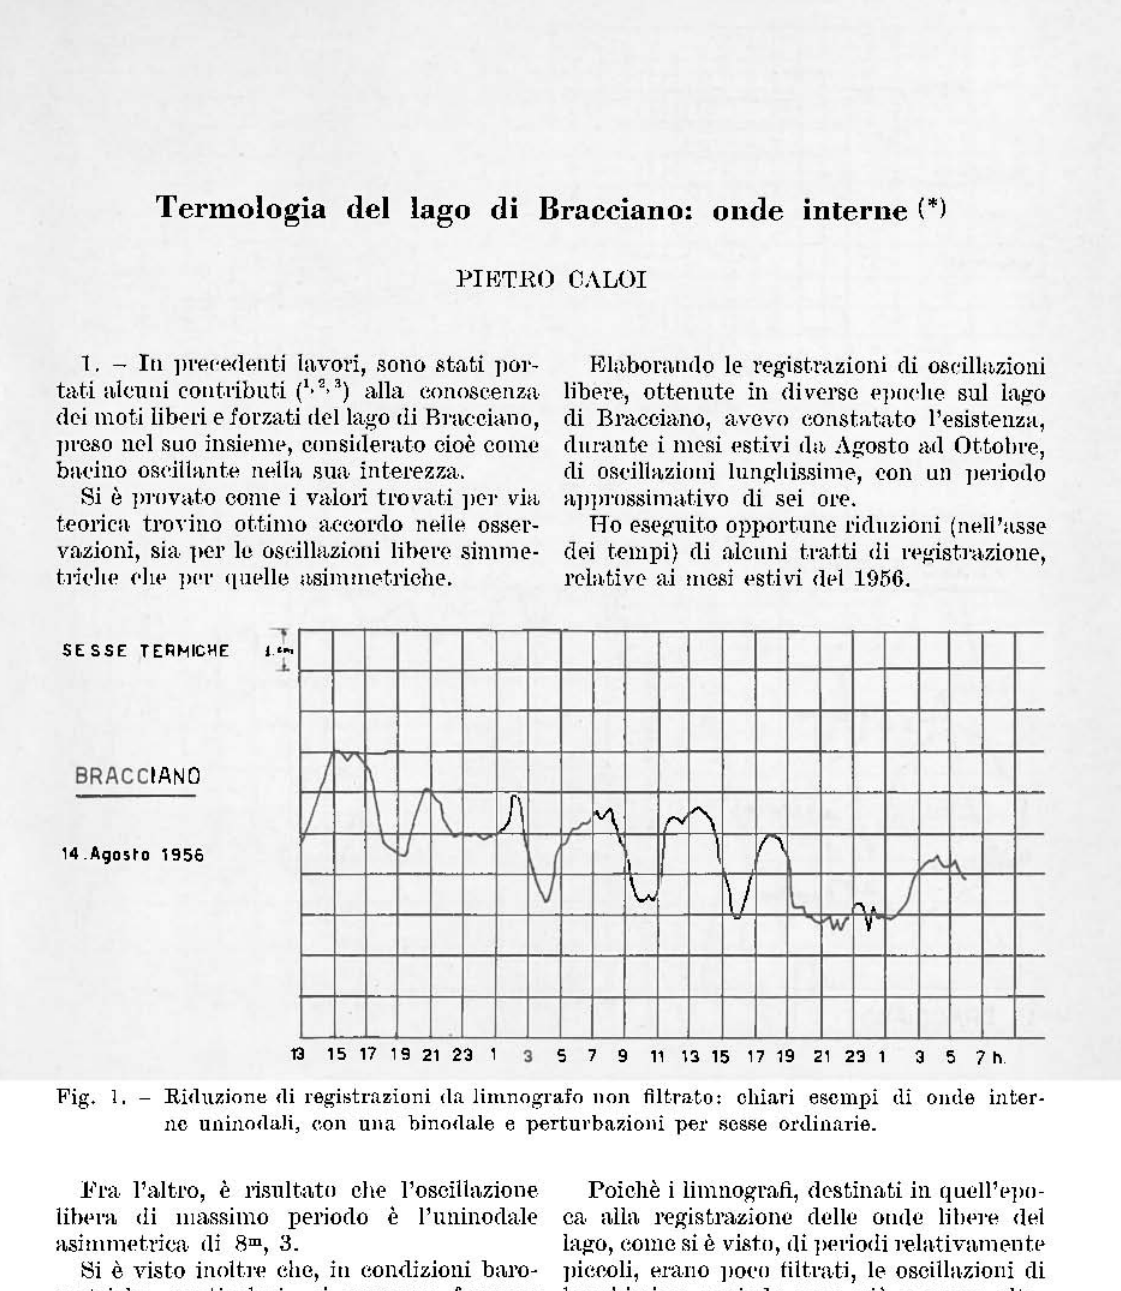
Fig. 1. - Rilluzione Ili registrazioni (la limnografo non filtrato: ehiari esempi di onde inter ne uninOllali, eon Ulla binOllale e perturbar,iOlli per sesse onlinaTie. ]<'ra l'altro, è risuJt.ato elle l'oscillazione lil)('\'a di m,'k'lsimo periodo è l'uninoda.Ie asimmet.rica· (]i 8 m , 3.